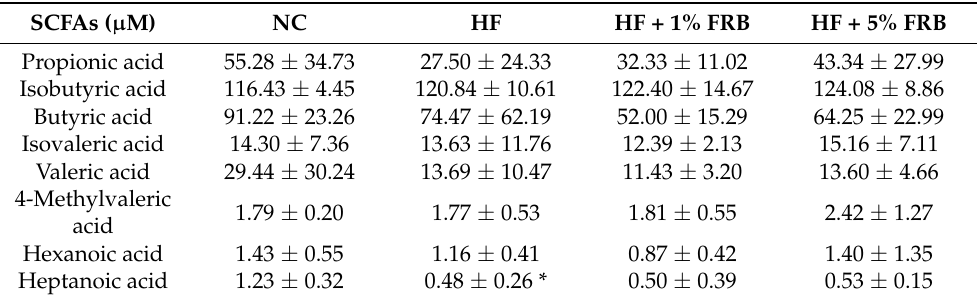
Table 7. Effects of the water extract of fermented rice bran (FRB) on fecal short-chain fatty acid (SCFA) concentrations in aged rats with high-fat (HF) diet